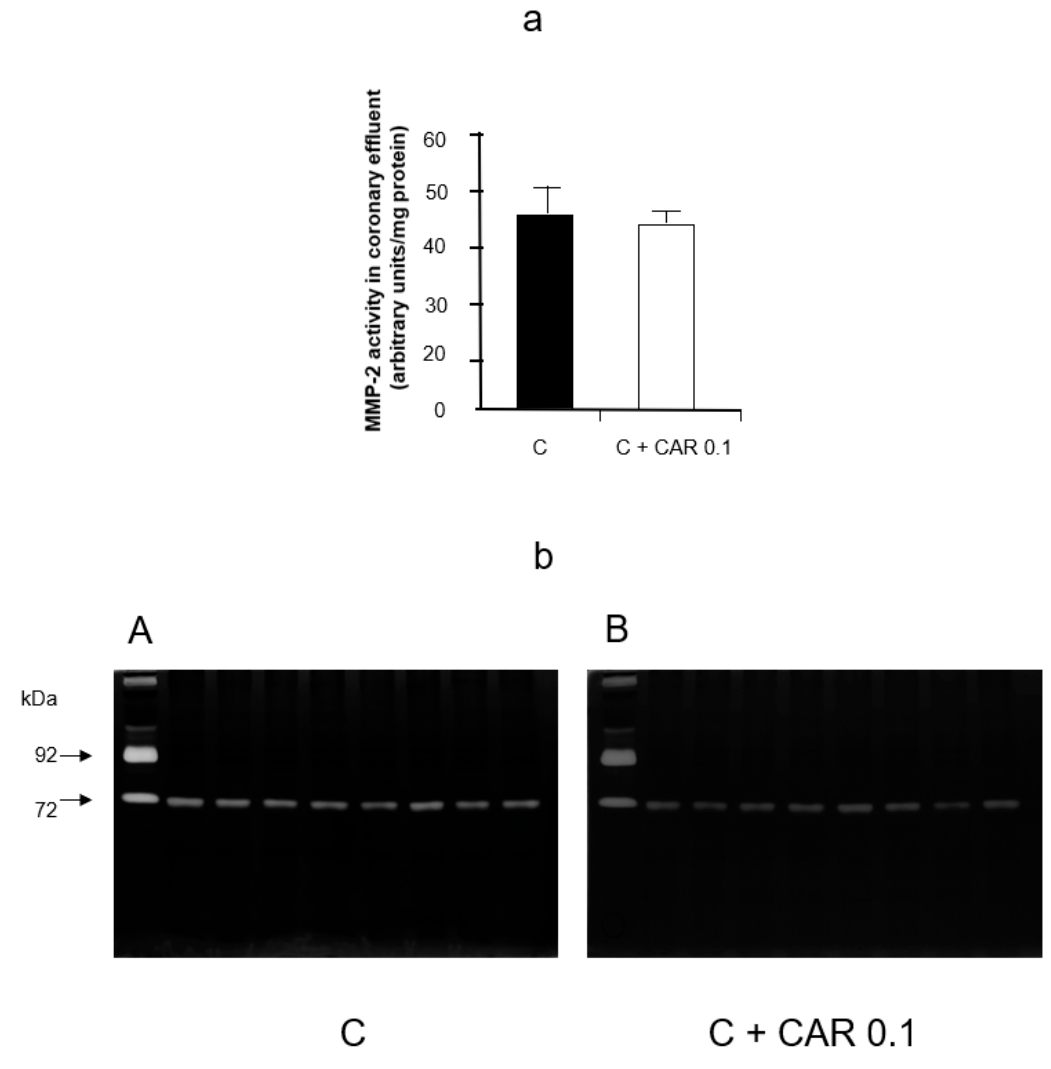
Figure 3. Effect of CAR on MMP-2 activity in vitro. ( a ) Densitometric analysis of gelatinolytic MMP-2 activities in control gel and gel incubated with addition of 0.1 µ M CAR. ( b ) Representative zymograms of MMP-2 activity in control gel ( A ) and gel incubated with addition of 0.1 µ M CAR ( B ). C —control group, C+ CAR 0.1—in control gel and gel incubated with addition of 0.1 µ M CAR. p > 0.05, n = 8, T-test.